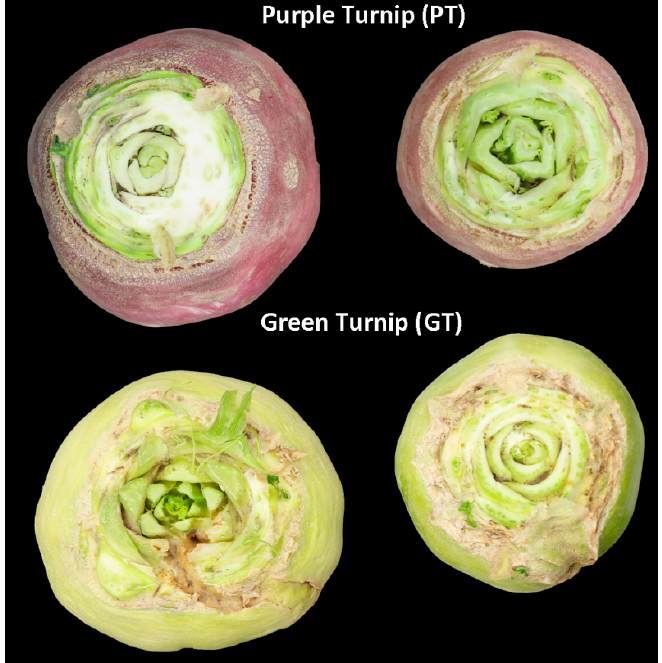
Int. J. Mol. Sci. 2019 , 20 , x FOR PEER REVIEW Figure 1. The phenotypes of young and mature purple-colored turnip and green-colored turnip roots. Table 1. Overview of the transcriptome sequencing dataset and quality check.